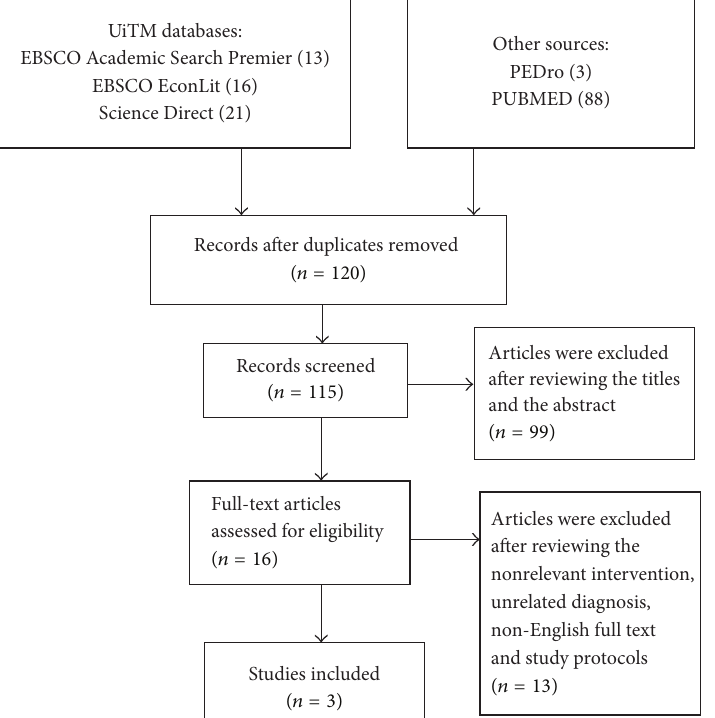
Figure 1: PRISMA flow diagram of search